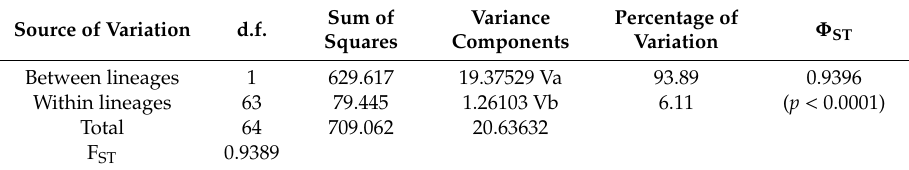
Table 5. ANOVA results between and within lineages based on COI a gene fragment. d.f. = degrees of freedom, Φ ST = Φ Statistic, FST = genetic di ff erences among